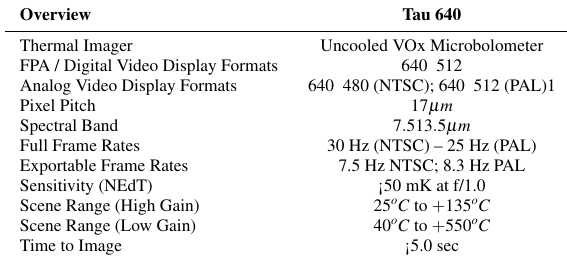
Table 1. Thermographic Payload: thermocamera Flir,